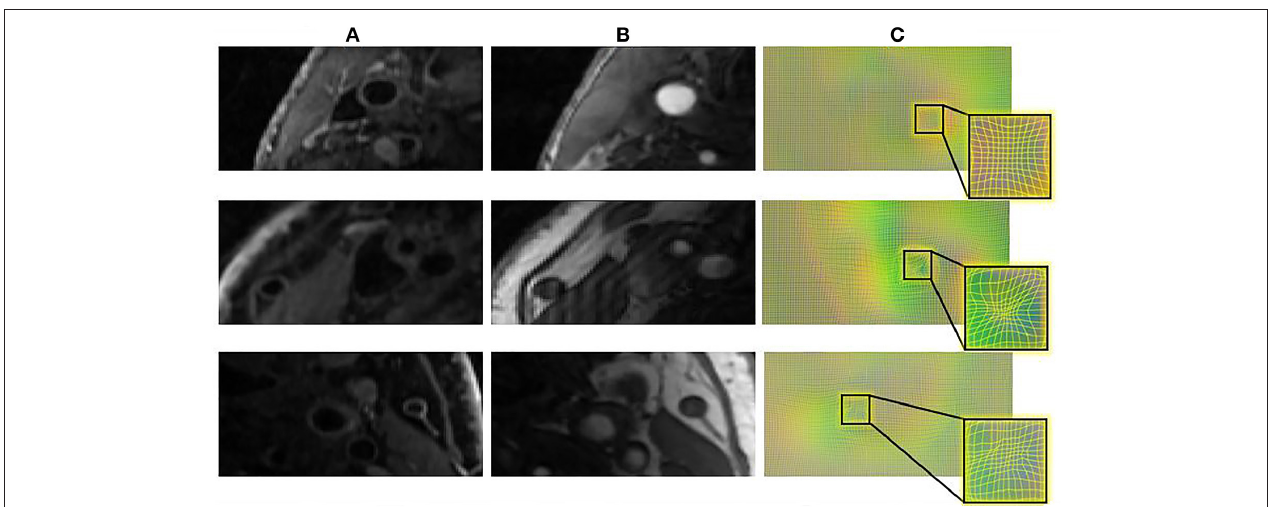
FIGURE 7 | The DVF visualization of carotid artery slices before and after registration. (A) The input T1GD image (B) the input TOF image (C) DVF visualization after registration.